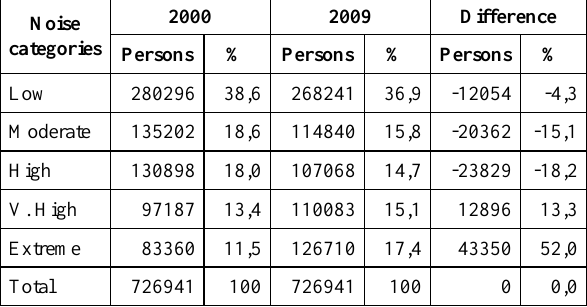
Table 8. Daytime population exposure to noise in Lisbon